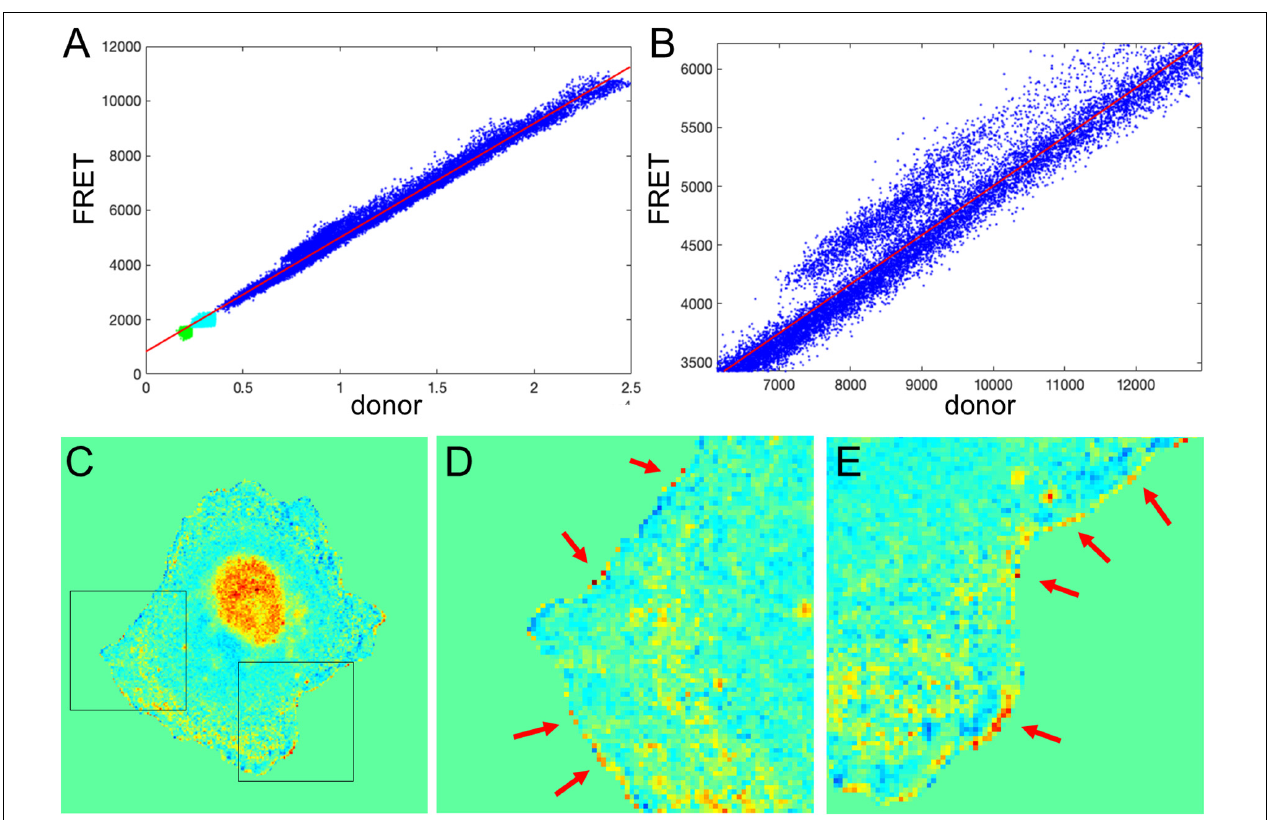
FIGURE 7 | Application of the mean background subtraction method to Asef biosensor data. (A) Uncorrected FRET vs. donor for each pixel. Blue indicates pixels with intensities above the mask threshold (i.e., inside the cell), green indicates pixels in the background with intensities below the mean plus three standard deviations of the noise in the box, and cyan indicates pixels in the background near the cell edge (with intensities between the threshold and mean + 3 std of the background noise). (B) A zoomed-in region of the image in panel (A) , confirming our theoretical assumption that there is strong basal activity of the GEF biosensor. (C) Ratio image resulting from the mean background subtraction method. Here we set the background level to the mean value of the ratio inside the cell (as in Figure 2B ). (D,E) Two different zoomed-in regions from the image in panel (C) (black boxes). Red arrows point to high ratio pixels on the edge of the cell. With MBS method, these pixels appear similar to the noise artifact seen Figure 1C , so NCF is needed to analyze these pixels